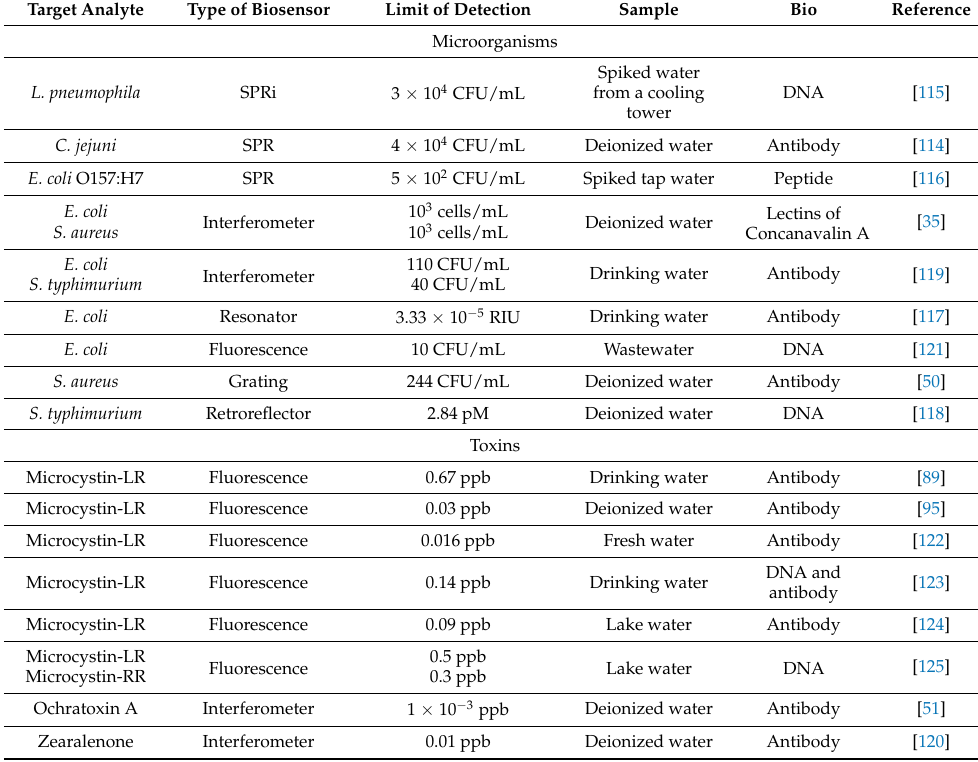
Table 5. Published work on detection of microorganisms and toxins in